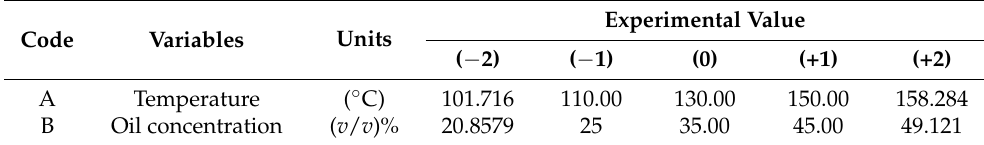
Table 2. Experimental values and levels of the selected independent factors for central composite design